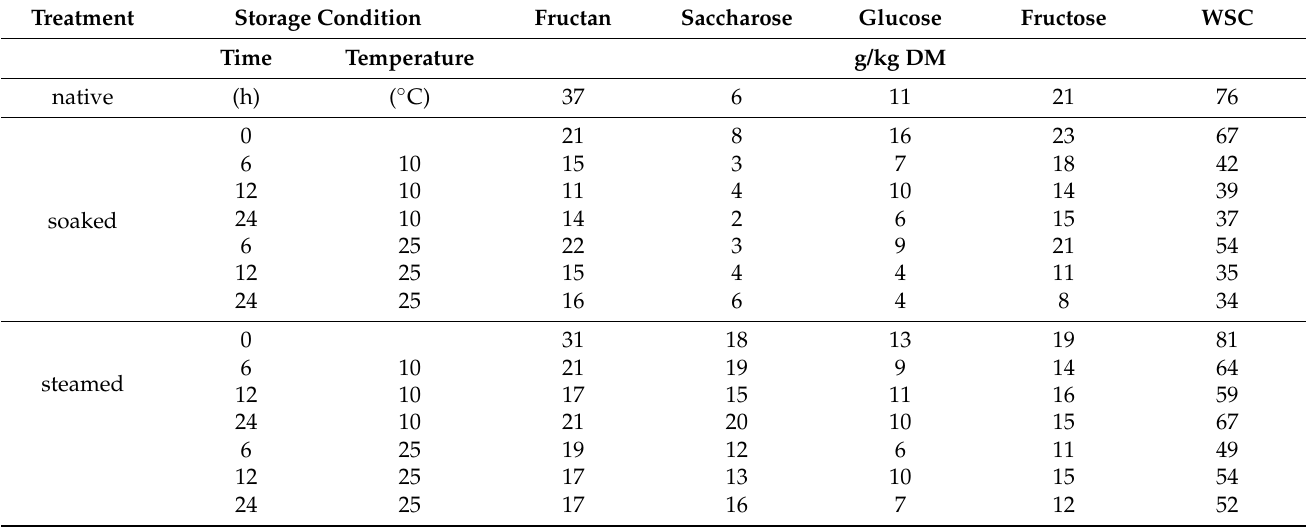
Table 3. Measured contents of water-soluble carbohydrates in the native and treated hay.